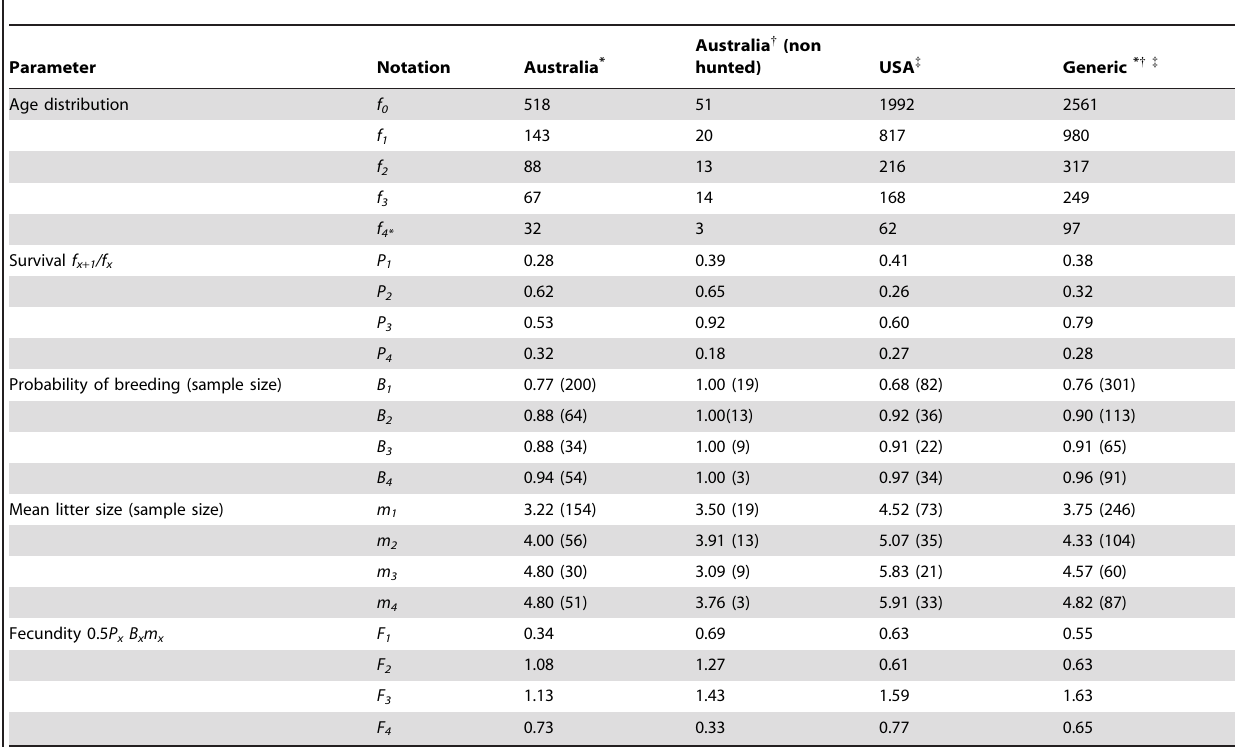
Table 1. Demographic data used to define projection matrices for three independent red fox populations and a ‘generic’ population based on data from the three other